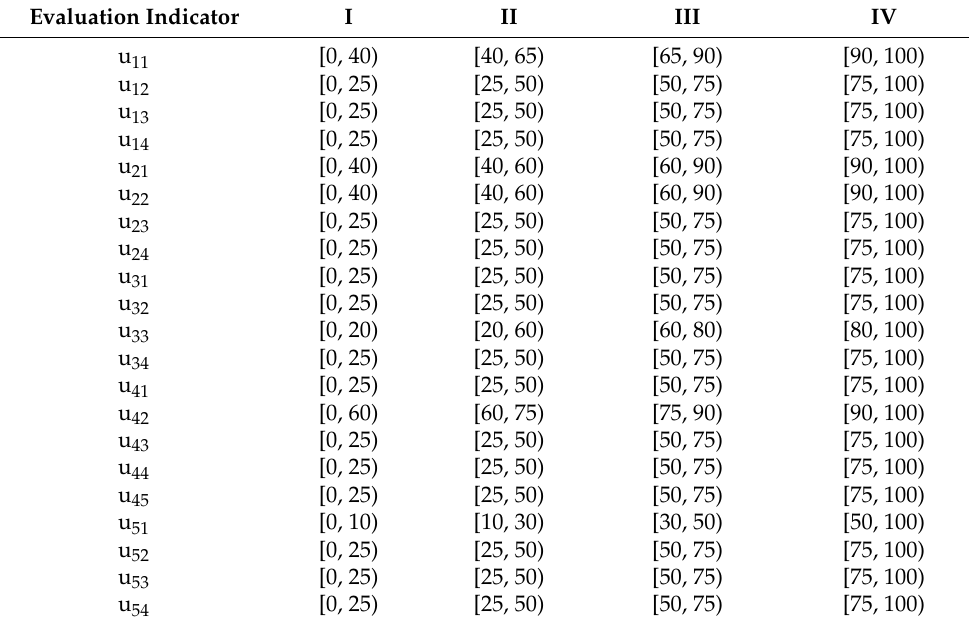
Table 14. Rating criteria of the LRS evaluation